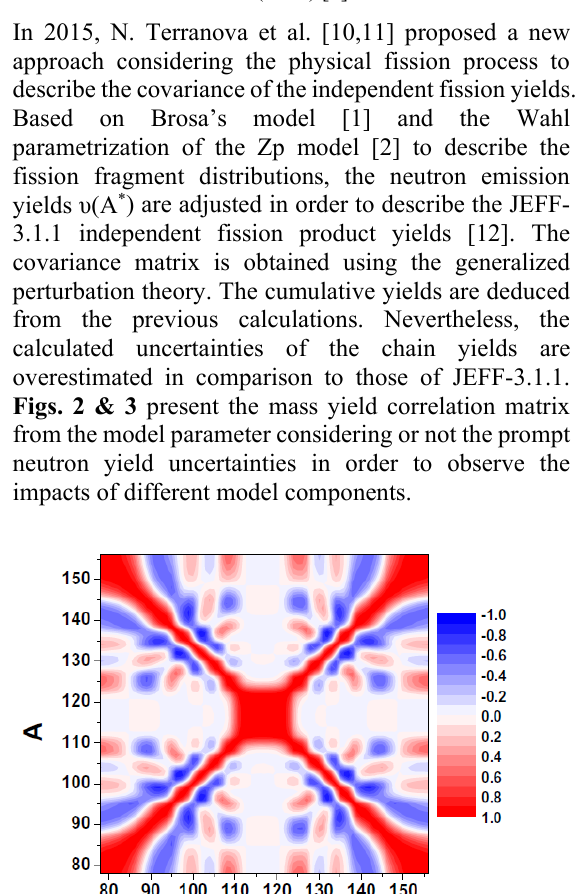
Fig. 1. Mass yield correlation matrix from K. Tsubakihara et al. (2021) [5].